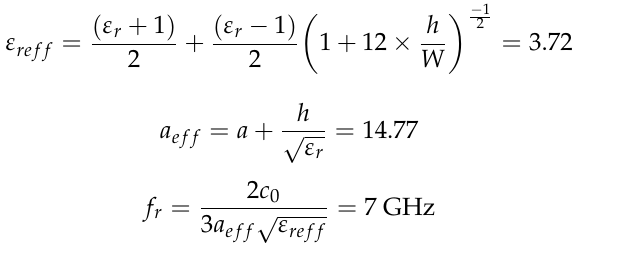
Figure 2. Step-by-Step design S-parameter response of Proposed antenna.